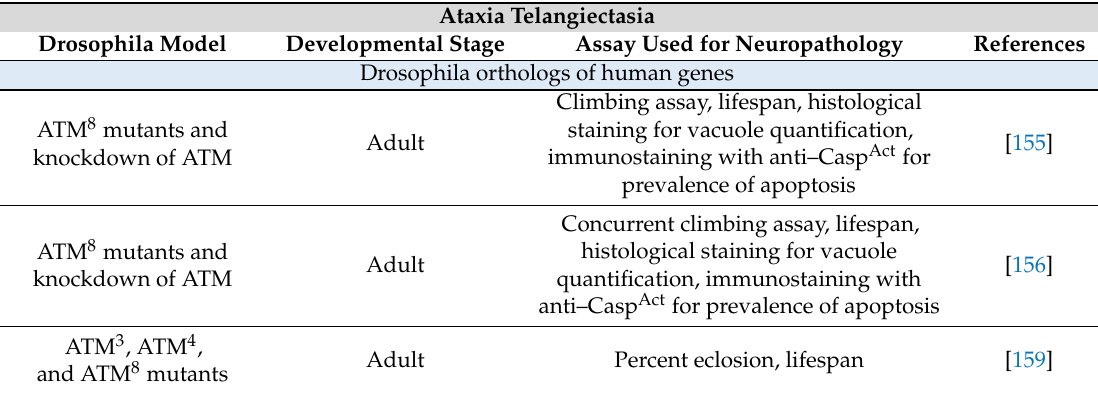
Table 5. Drosophila models of Ataxia